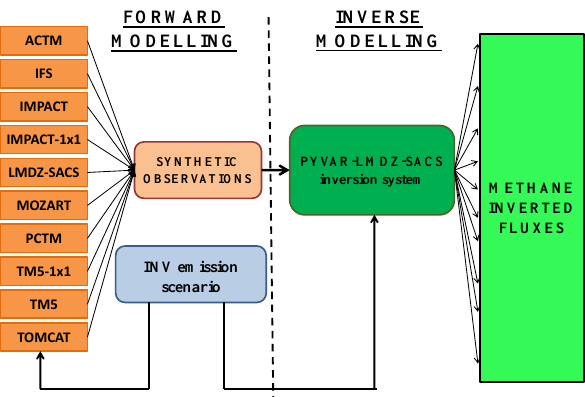
Fig. 1. Schematic showing the methodology of our experiment. Synthetic observations are created from the outputs of TransCom- CH 4 forward modelling simulations. The TransCom-CH 4 INV sce- nario is used both as the target CH 4 flux for forward modelling and as prior fluxes in the inversions. Several CH 4 fluxes are derived us- ing the PYVAR-LMDZ-SACS inversion system for